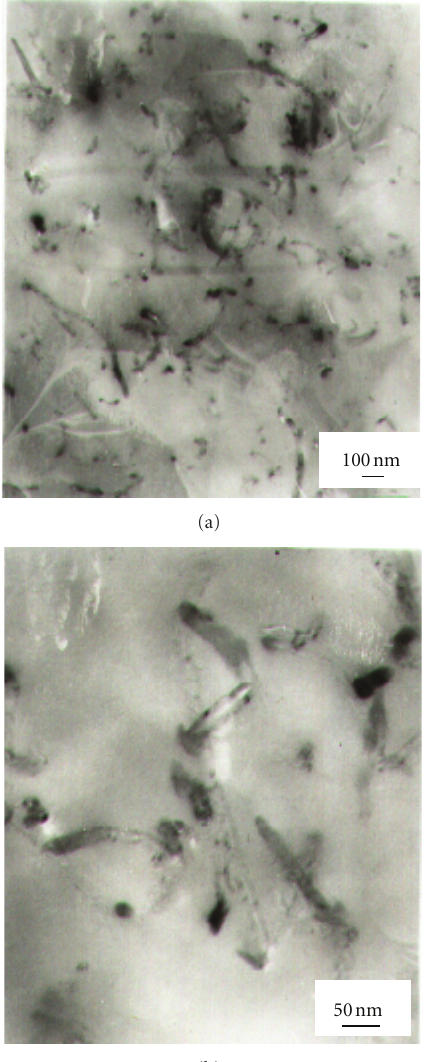
Figure 5: The TEM images of MWNTS OH /epoxy resin nanocom-